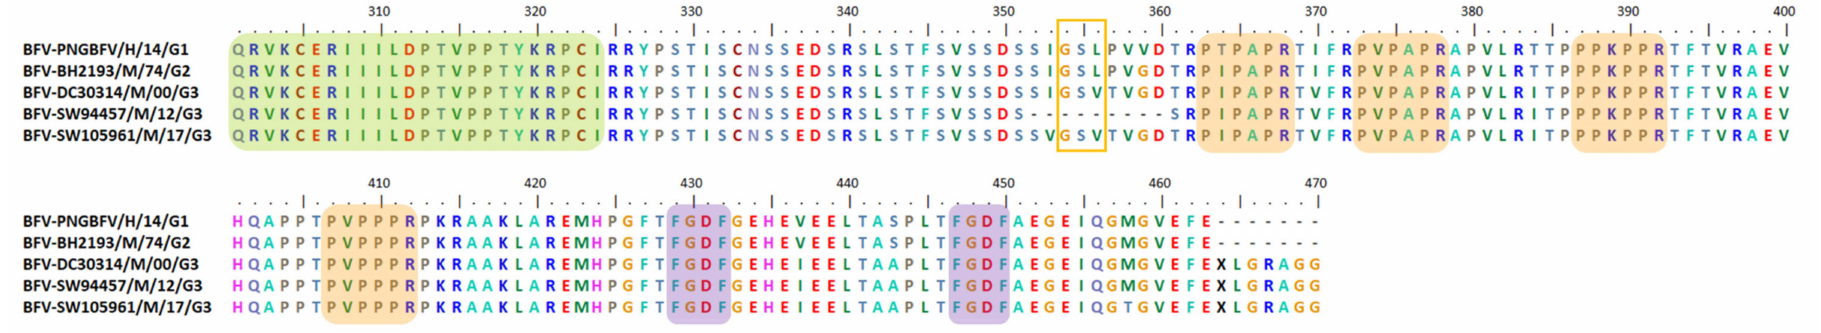
Figure 7. Important motifs and mutation events in BFV nsP3 HVD. The HVD starts at position 325. It consists of four P-rich regions at positions 363–368, 373–378, 387–392, and 407–412 (peach) as well as two FGDF-like motifs at positions 429–432 and 447–450 (purple). The SW94457 has a 9 aa deletion motif at position 352–350. A predicted conserved motif for GS(L/V) has been observed at position 355–356 (orange